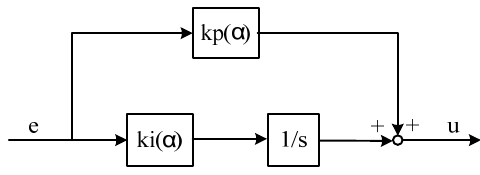
Figure 4. PI gain scheduled controller: case 1.